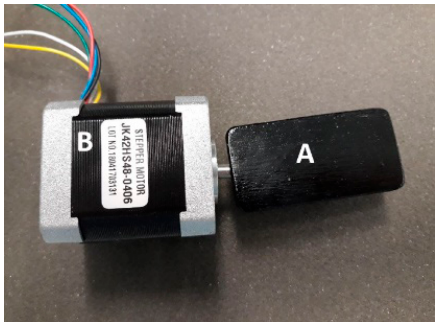
Figure 5. View of the β observation angle adjustment circuit: A—stand for the tested component; B—stepper motor to adjust the observation angle β .